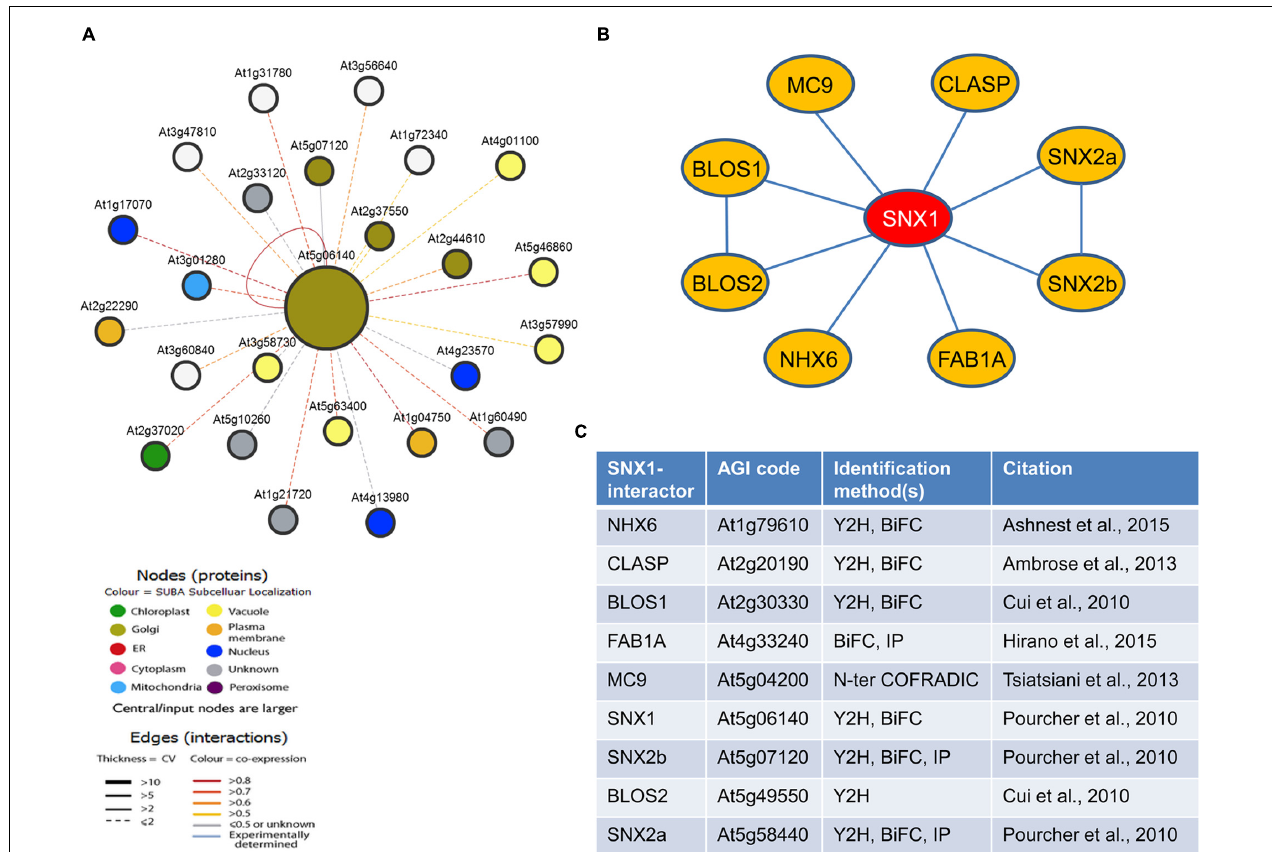
FIGURE 1 | Protein interactions of SNX1. (A) Prediction-based SNX1-interaction map generated using Arabidopsis Interactions Viewer. (B) SNX1-interaction map based on literature data. Known interactions between BLOS1 and BLOS2, and SNX2a and SNX2b are also presented. (C) A list of the known SNX1-interacting proteins. The list includes the methods by which interaction was inferred, as well as the corresponding citation. Y2H, yeast two-hybrid screen; BiFC, bimolecular fluorescence complementation; IP, coimmunoprecipitation; N-ter COFRADIC, N-terminal combined fractional diagonal